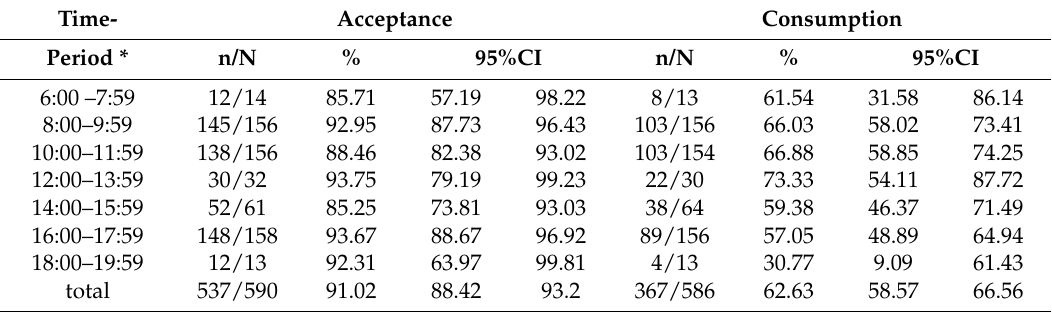
Table 7. Bait acceptance and—consumption and time point of bait offering (n = number of baits accepted, N—number of baits offered, 95% CI—95% confidence interval).